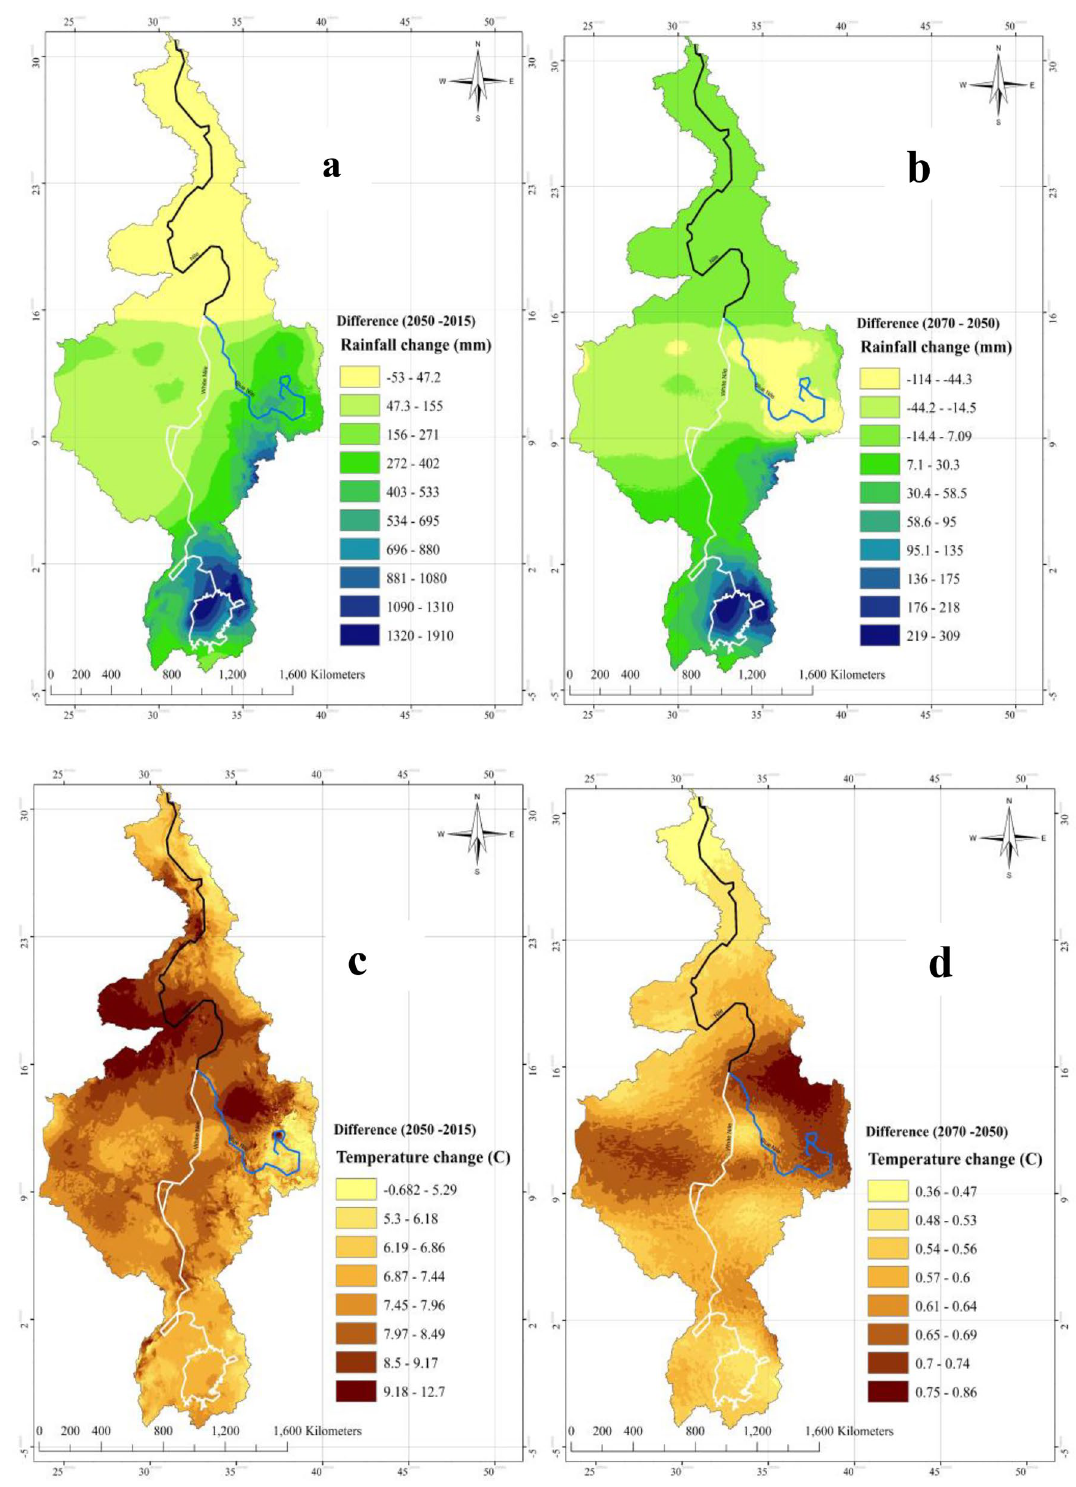
Figure 14. Future change of NRB’s annual precipitation ( a ) and surface temperature ( c ) in 2050, NRB’s annual precipitation and surface temperature in 2070 ( b , d ). In ( c – d ), warming trend over Sudan and Egypt will increase and the projected increase in mean temperature in this period is 6.82 °C between 2015 and 2050, while between 2050 and 2070 warming trend will continue but at a lower rate than the previous period as the difference between mean temperature in 2050 and 2070 is 0.79 °C. The increases of mean temperature in Ethiopia and Eritrea between 2015–2050 and 2050–2070, is about 6.08 °C, and 0.56–0.58 °C, respectively. While in Kenya, Tanzania, Rwanda, Burundi, Uganda, and Congo increase in mean temperature is 5.5 °C between 2015–2050 and 0.48 °C between 2050 and 2070. The maps were generated with ArcMap Version 10.1 (http:// www. esri. com/ en/ arcgis/ arcgis- for- deskt